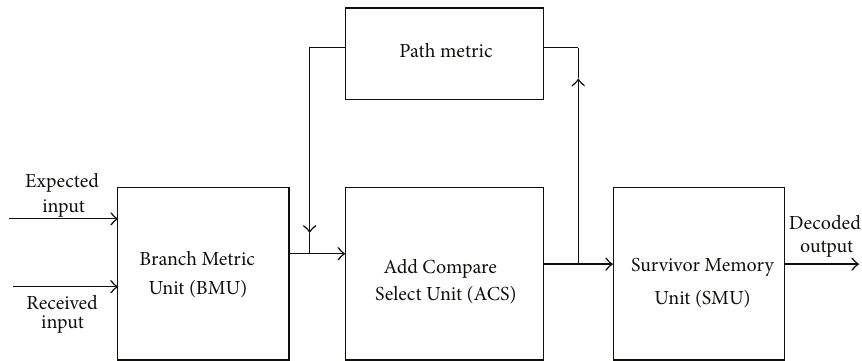
Figure 1: Block diagram of the Viterbi decoder.